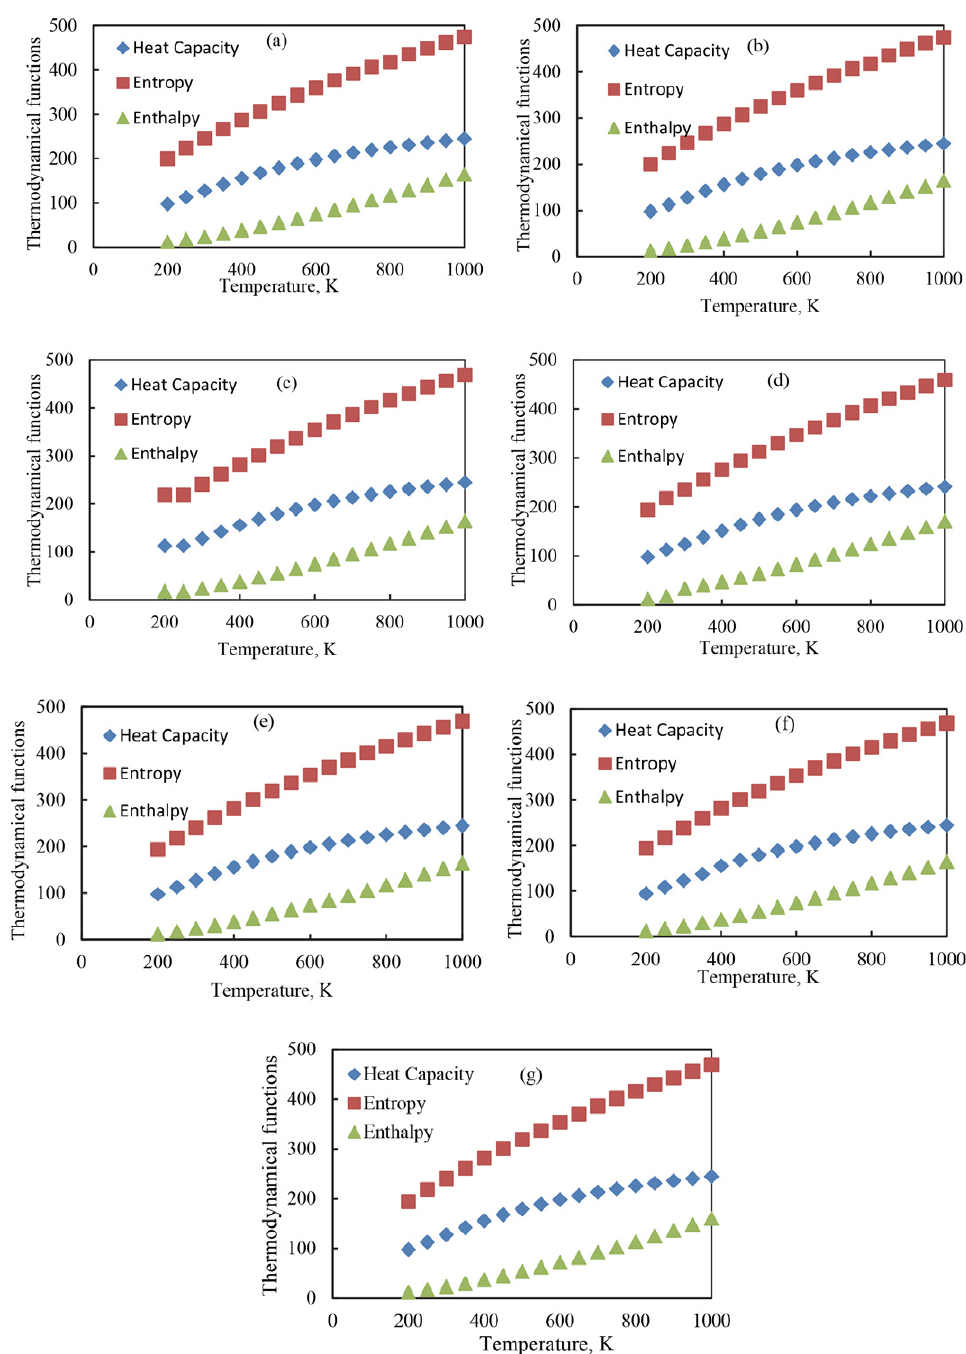
Figure 3. Correlation graph of heat capacity, entropy and enthalpy with temperature for Iopamidol